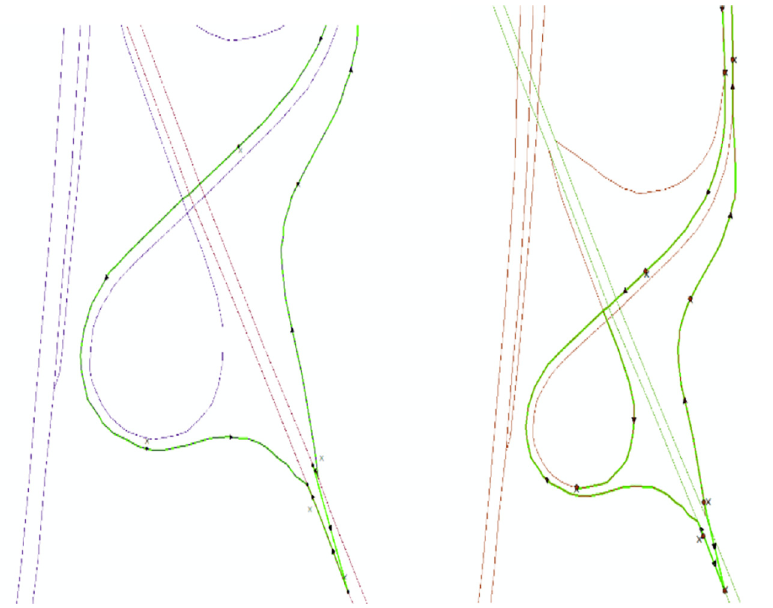
Figure 6 (left) is the result of matching the complex intersection using the algorithm of this paper. Figure 6 (right) is the result of matching the same position by the weight method. It is found through observation that the matching points of the matching algorithm in this paper are all matched correctly, and the weighting method has a point on the lower left corner of the island that is misaligned and matched to the adjacent road segment. The reason is that the point is closer to the inner side of the roundabout.